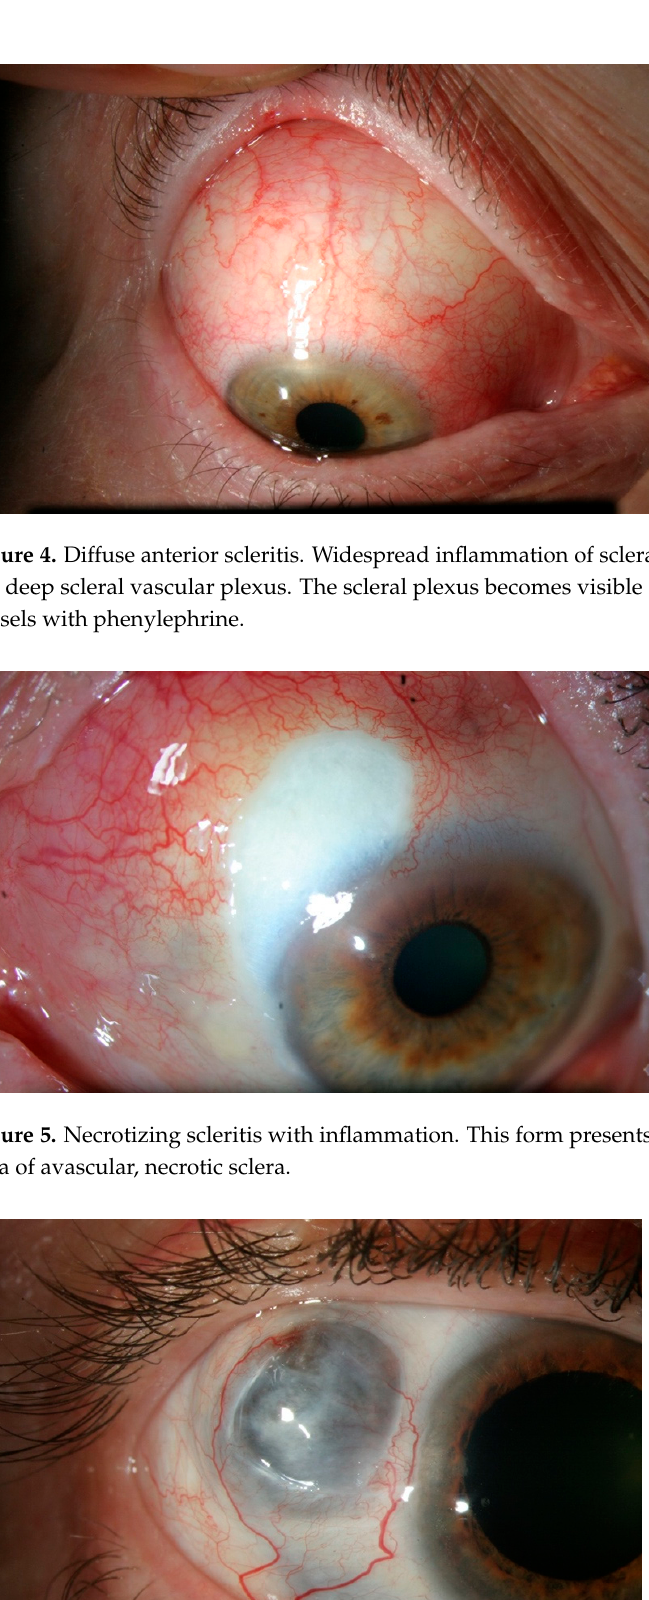
Figure 6. Necrotizing scleritis without inflammation, or scleromalacia perforans. This form presents with no inflammation and no pain, and almost complete destruction of scleral and episcleral tissue in one or more necrotic patch. The greyish appearance comes from the visible uveal tissue underneath.